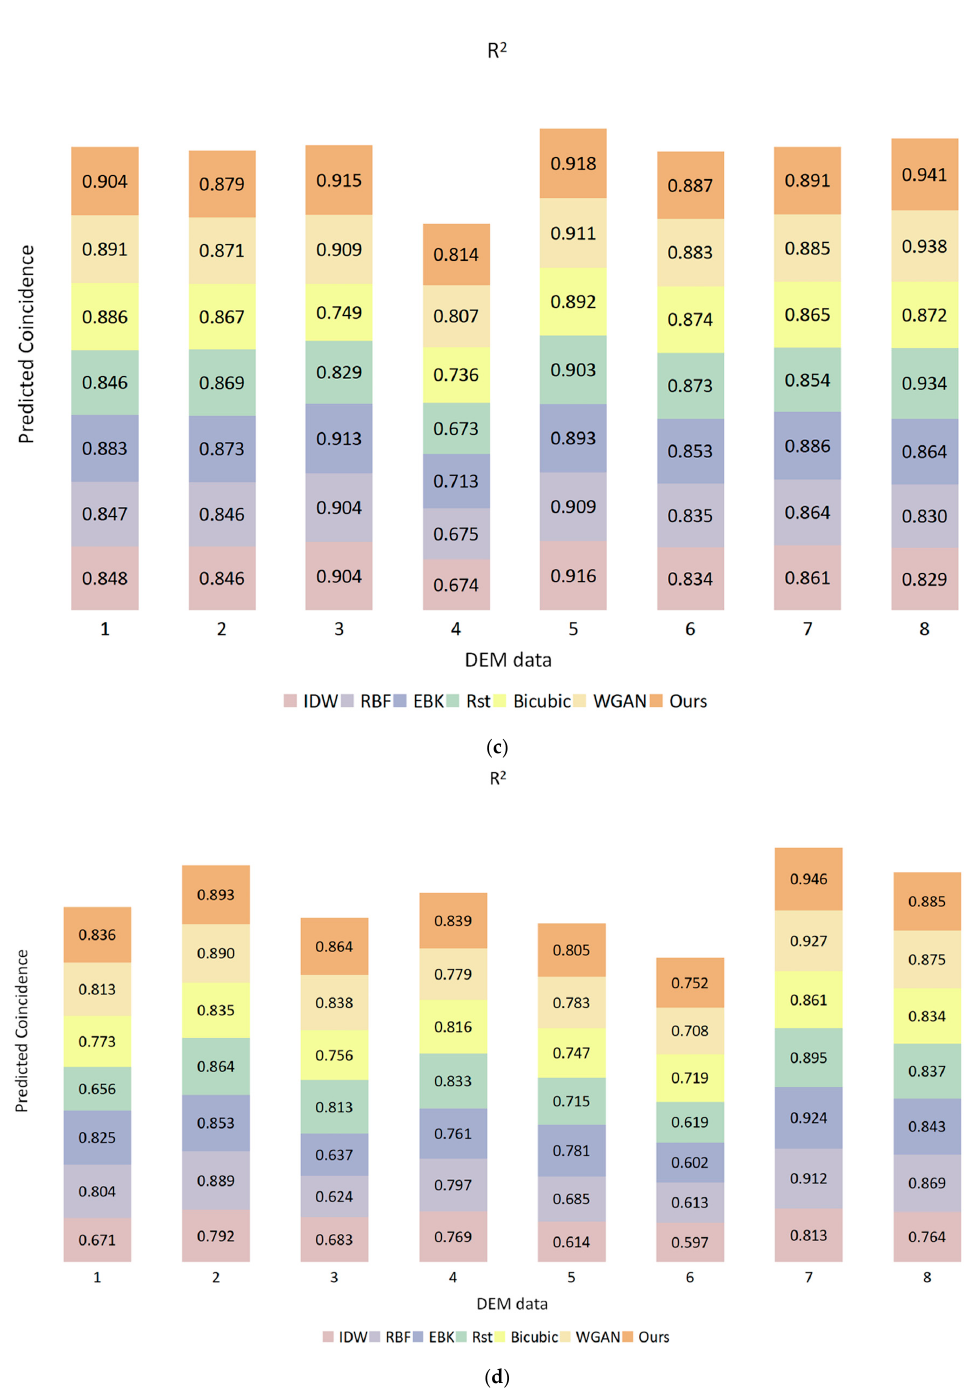
Figure 12. Coincidence prediction. ( a ) Test data for Norway (gentle terrain); ( b ) test data for Norway (complex terrain); ( c ) verification data of a place in Jiangsu province; and ( d ) verification data of a place in Sichuan province.